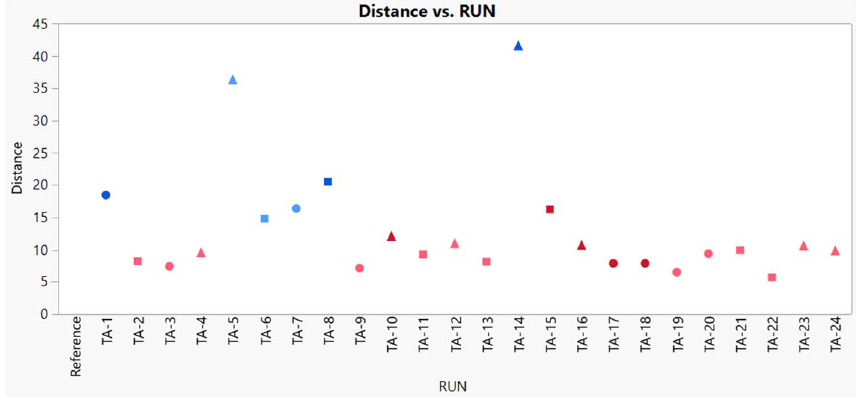
Figure 6. The distance between samples and reference. TA-1 to TA-24 refers to the samples obtained from the designed 24-run experiment in Ambr. Basal medium CD14 is dot, basal medium CD 15 is square, Dynamis is triangle, FEED B is blue, PFF06 is red, galactose addition on day 12 is light color and day 13 is dark color. The image was created by JMP V15 (http:// www. jmp.